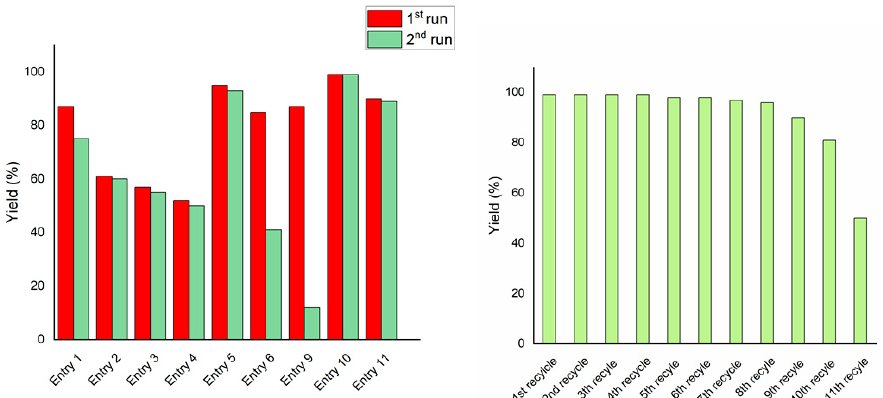
Figure 1. ( a ) Yield of entries 1–6 and their first recycling. Entries refer to Table 2. ( b ) Recycling experiments of FUR hydrogenation in the presence of a FUR/[Ir(COD)Cl] 2 / L5 /NaOH ratio of 1.0/0.1/0.1/0.2 mol/mol at 80 °C, P H2 40 bar, for 18 h; solvent: THF/H 2 O (3 mL/3 mL).